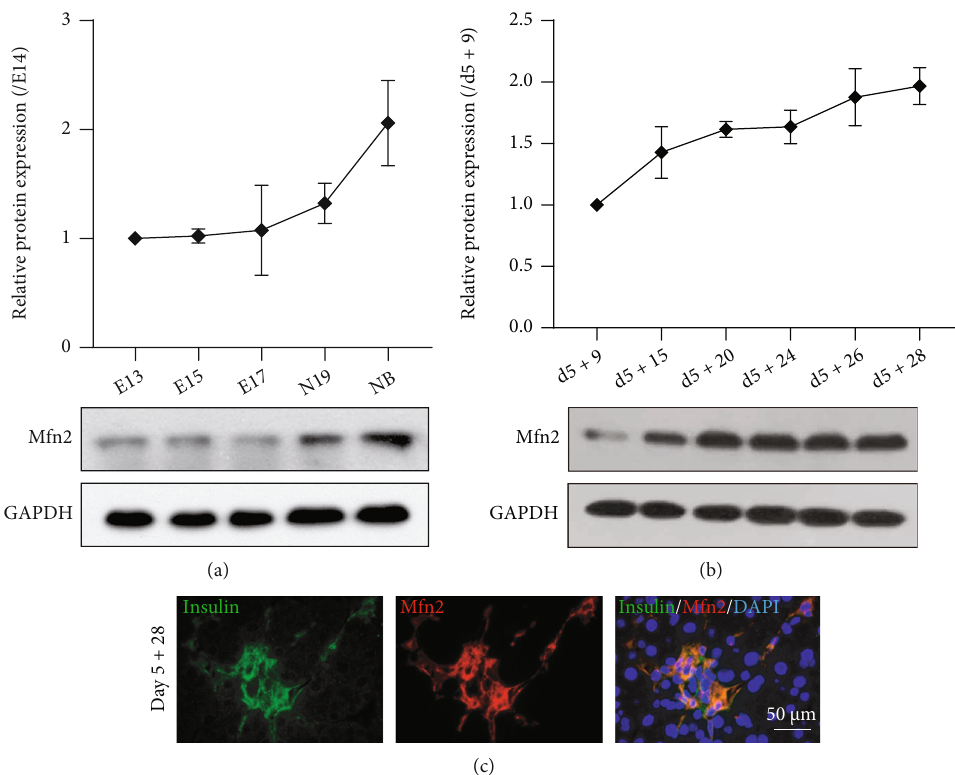
Figure 2: Mfn2 expression during pancreas maturation in vivo and in vitro. (a) Protein expression of Mfn2 in pancreas at embryonic days E13, 15, 17, and 19 of gestation and newborn mouse, n = 3 . (b) Mfn2 expressed during β cell di ff erentiation stage, n = 3 . (c) Immuno fl uorescence staining detected the coexpression of Mfn2 with insulin at termination day 5 + 28 . Bar = 50 μ